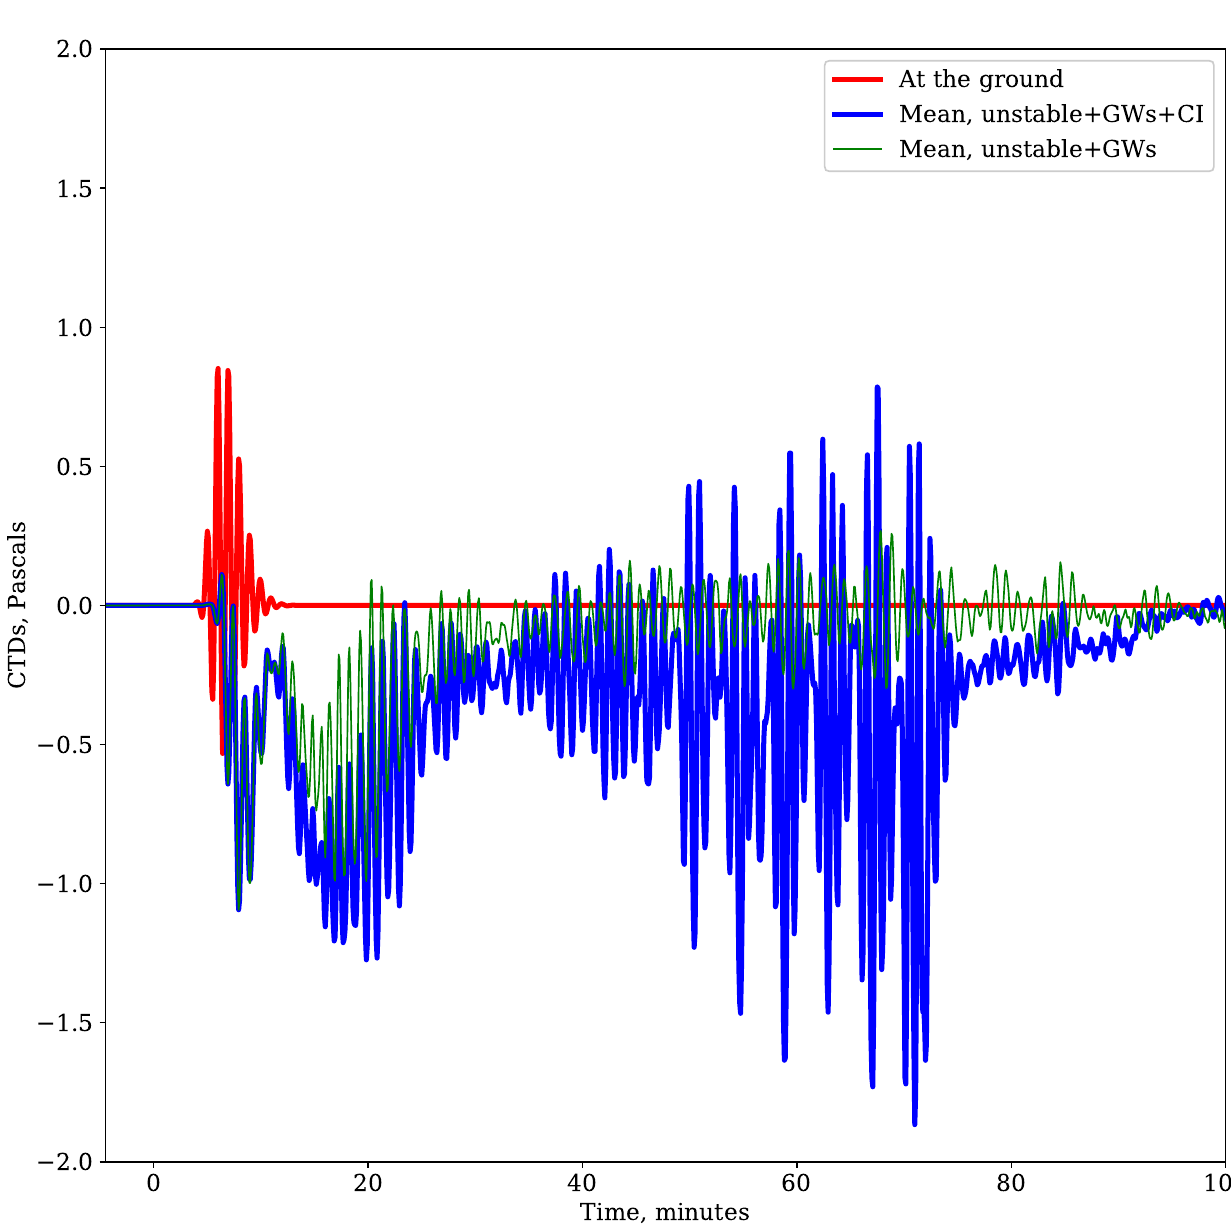
Figure 8. It presents the time vs. pressure disturbances over the epicenter. The curves correspond to the ground pressure disturbance and mean pressure disturbance from lower tropospheric altitudes between 1 and 15